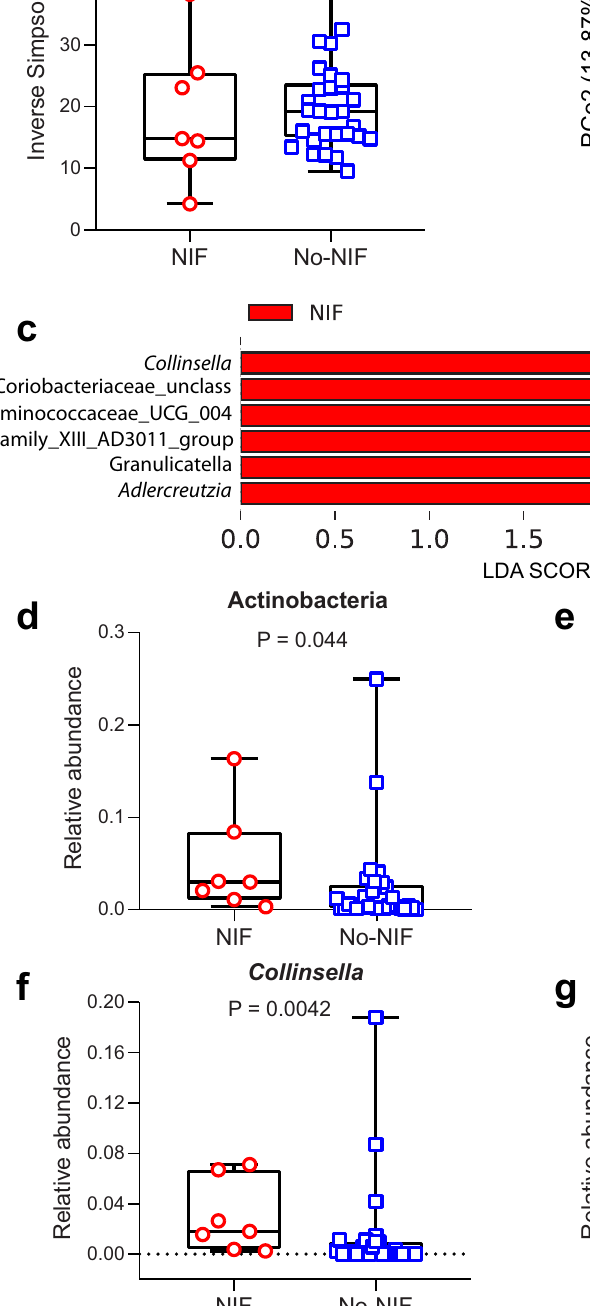
microbiota with the NIF phenomenon revealed by